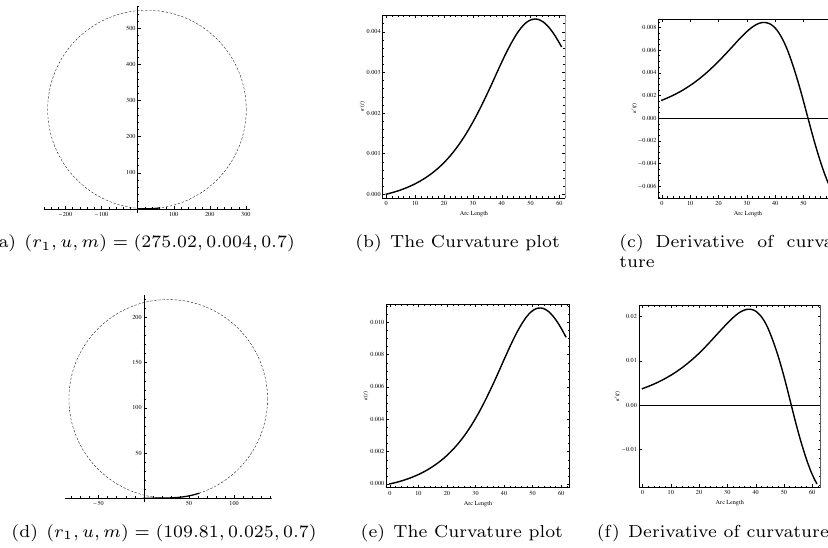
Figure 9. J-shaped transition curves (left) with single curvature